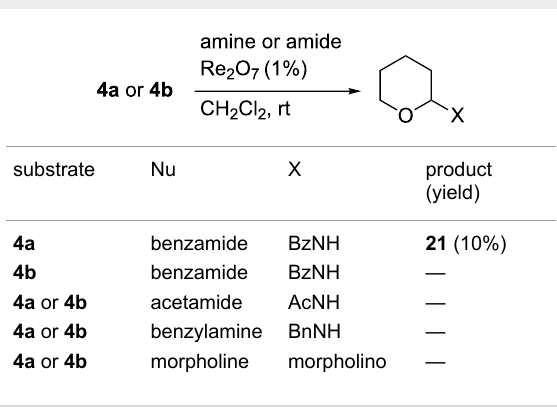
Table 6: Attempted synthesis of N , O -acetals.